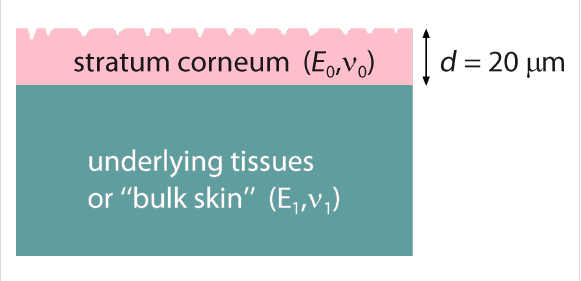
Figure 6: The model of the skin used in the calculations. The elastic modulus of the bulk skin is E 1 = 20 kPa, and the Poisson ratio is ν 1 = 0.5. The 20 μ m thick top layer ( stratum corneum ) has a Young’s modulus of E 0 = 7 MPa, in the wet state and of E 0 = 1 GPa, in the dry state with a Poisson ratio of ν 0 = 0.5. A penetration hardness of 50 MPa was assumed for dry